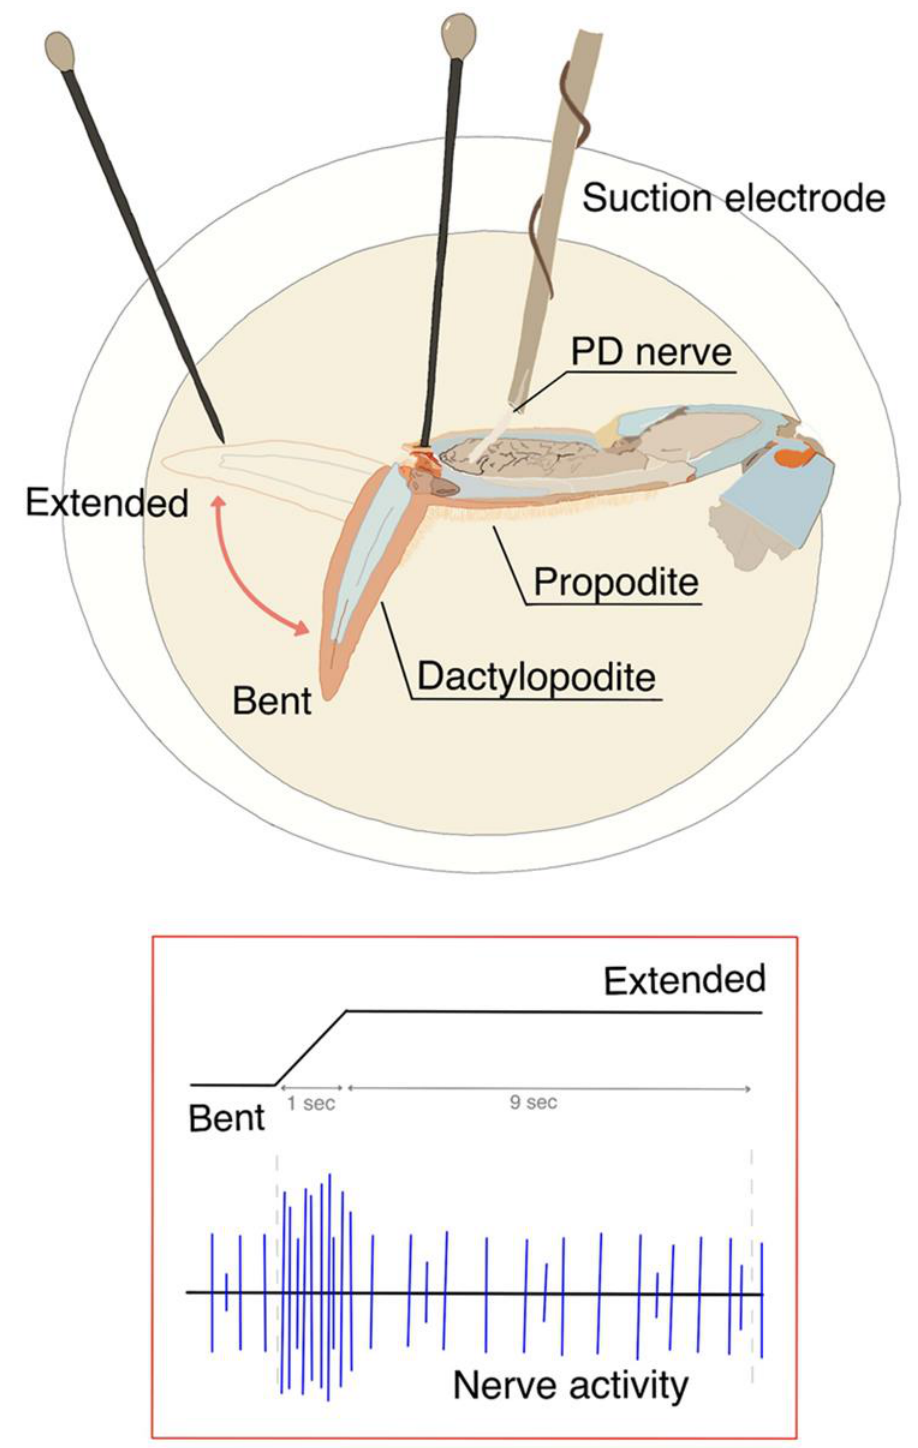
Figure 1. The first or second walking leg of the crab was used to expose the PD organ and associated nerve to various compounds. The joint was initially bent at 90 degrees, then extended out straight within 1 s, and then held for at least another 9 s. The entire 10 s was then used for analysis in the number of spikes that occurred while bathed in different solutions.